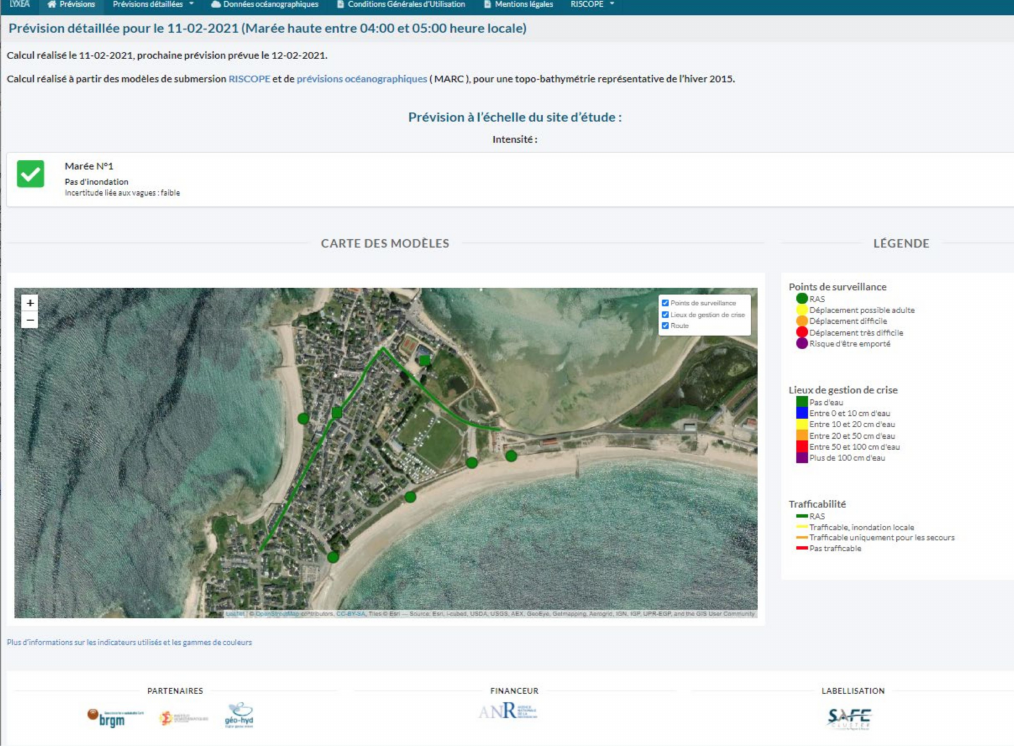
Figure A6. Screen capture of the FEWS webpage showing indicators I 1 to I 6 and I 9 to I 13 . The other indicators are shown only when C(I 1 ) > 2, which is not the case for the present